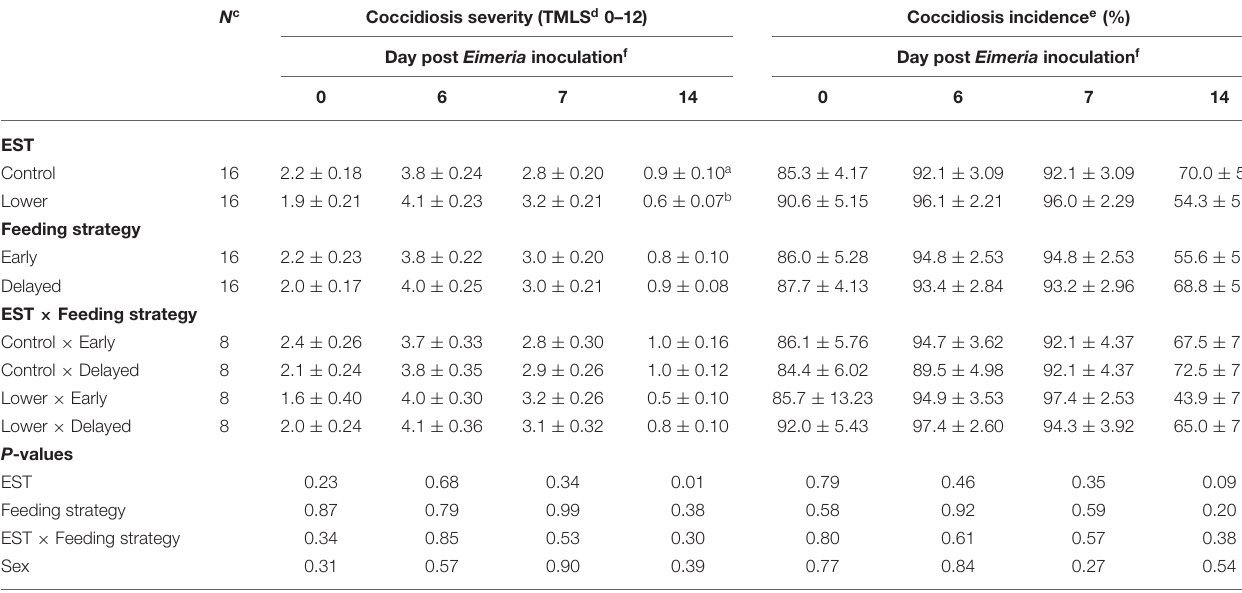
TABLE 3 | Effect of eggshell temperature ( EST ) during late incubation [ ≥ E17–E19.5; 37.8 ◦ C ( control ) or 36.7 ◦ C ( lower )] and/or feeding strategy after hatch [immediate access to feed and water ( early ) or 51–54-h deprivation ( delayed )] on coccidiosis of broilers at d 0, 6, 7, or 14 post Eimeria inoculation (d 21 post hatch) to induce necrotic enteritis (mean ±